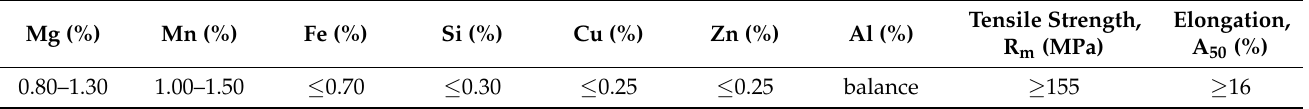
Table 1. Chemical composition and mechanical properties of EN AW-3004 according to PN-EN 573-3:2019-12 [51] and EN 4852: 2016 + A1:2018 [52],